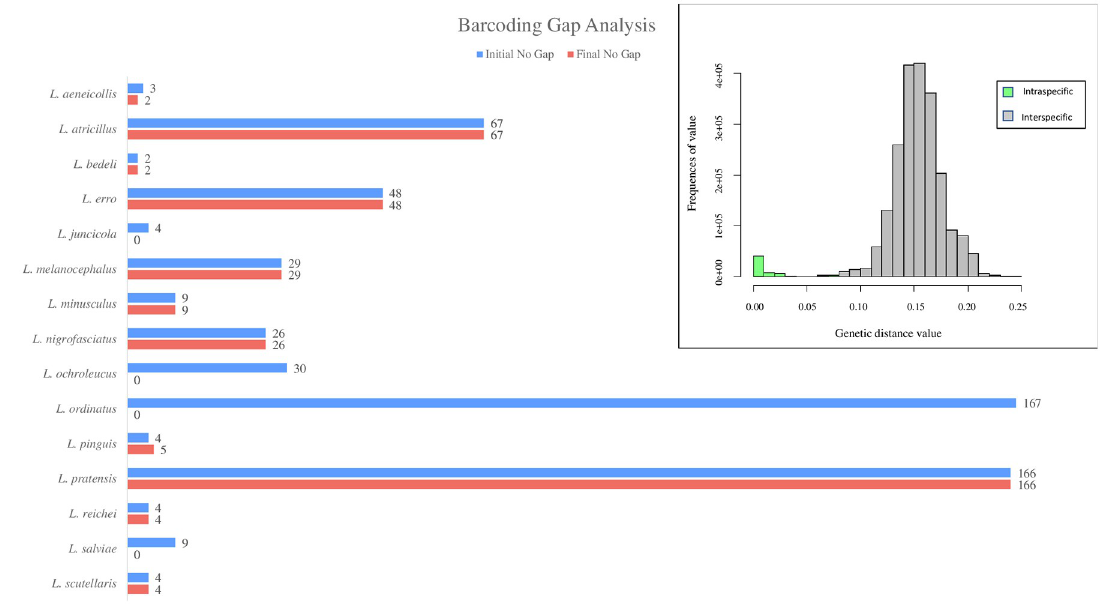
Fig 3. Results of the barcoding gap analyses for the original dataset and the final dataset. The number of absences of barcoding gap for each species is reported.